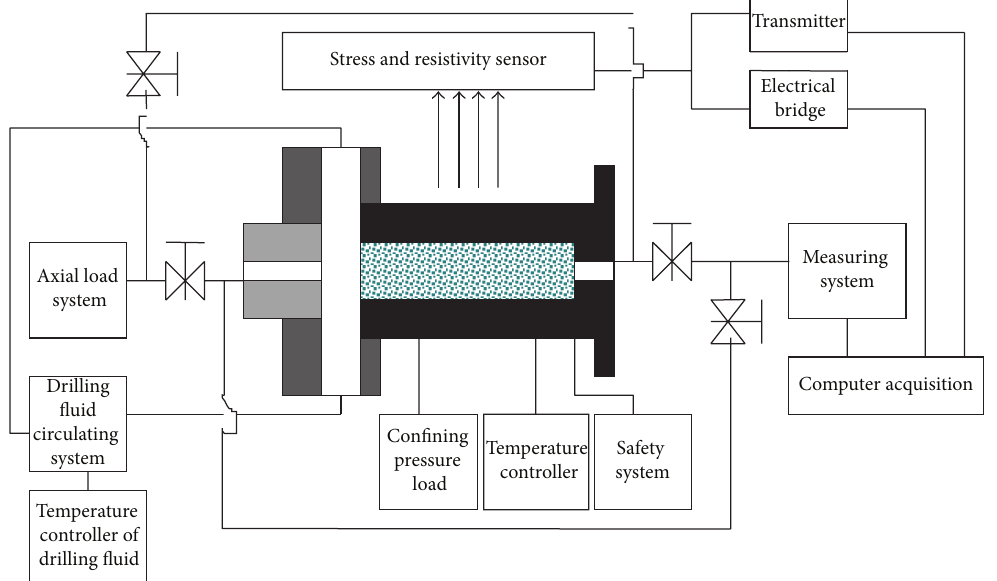
Figure 1: The experimental equipment